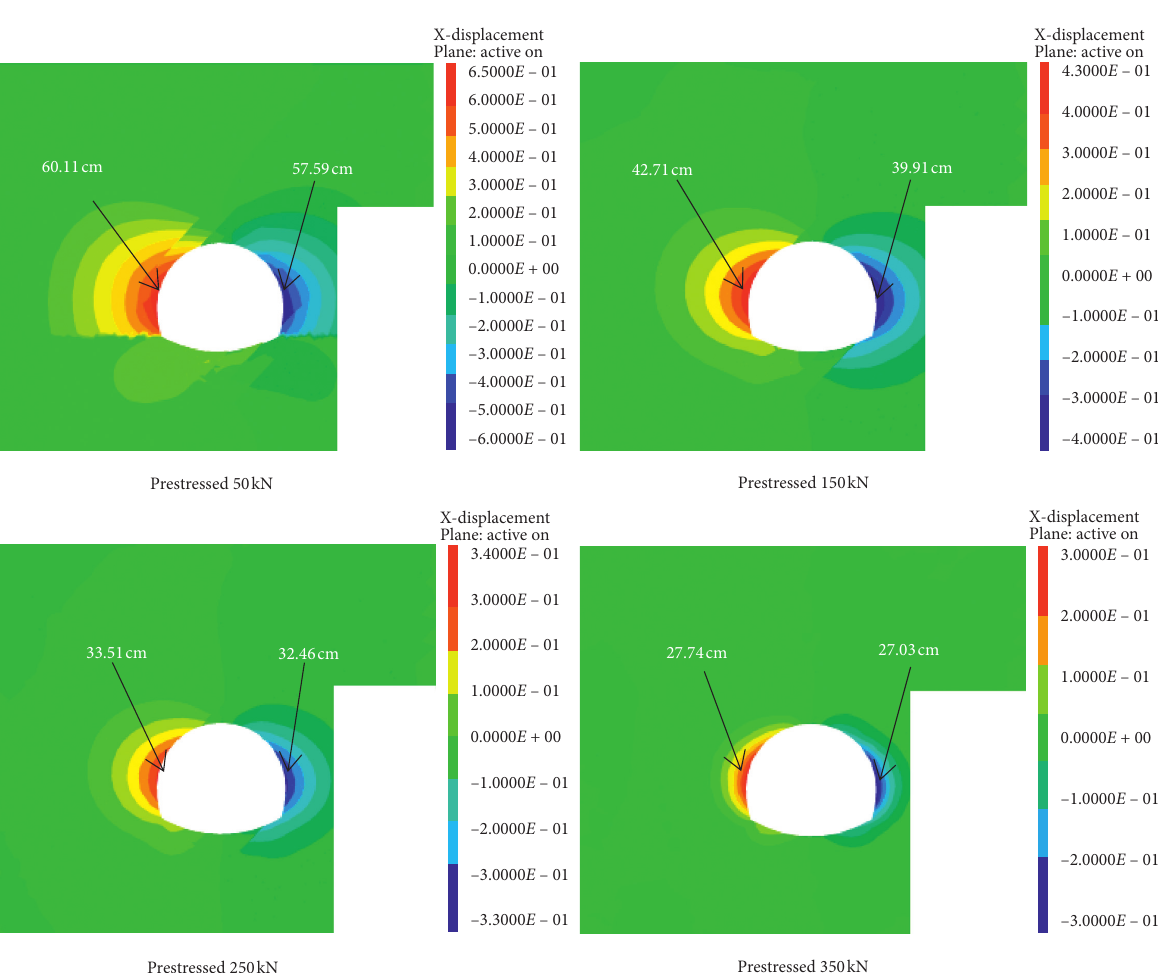
Figure 25: Horizontal displacement under different prestressing (Section